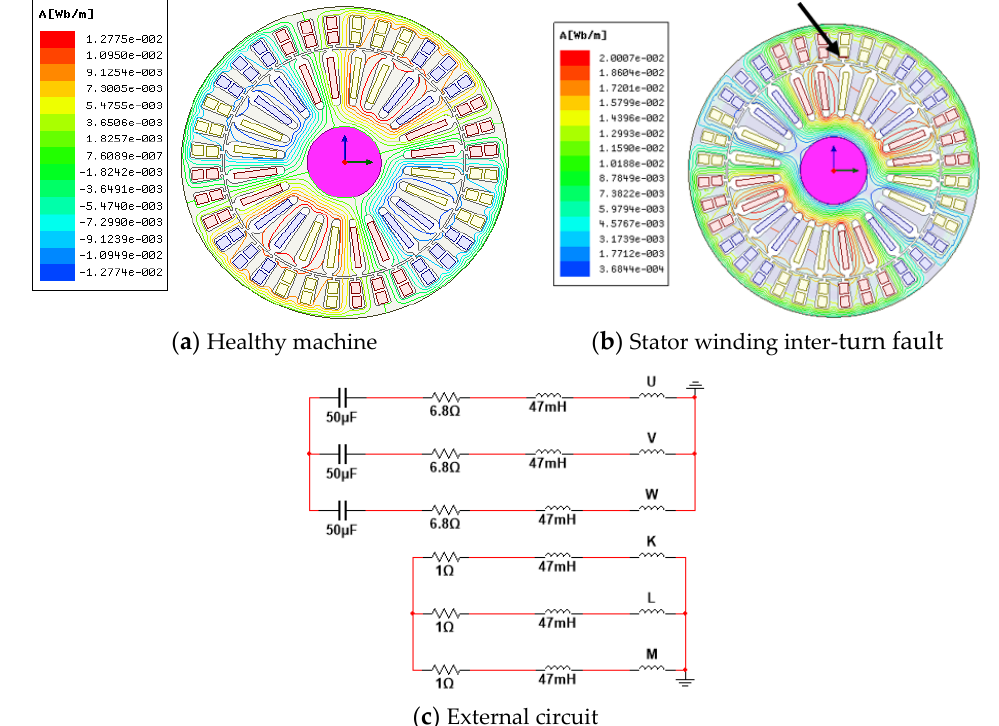
Figure 1. ( a ) Geometry of wound-rotor induction generator model with flux lines distribution; ( b ) Flux lines distribution with stator winding inter-turn fault indicated (by arrow); ( c ) External circuit of the investigated wound-rotor induction generator.